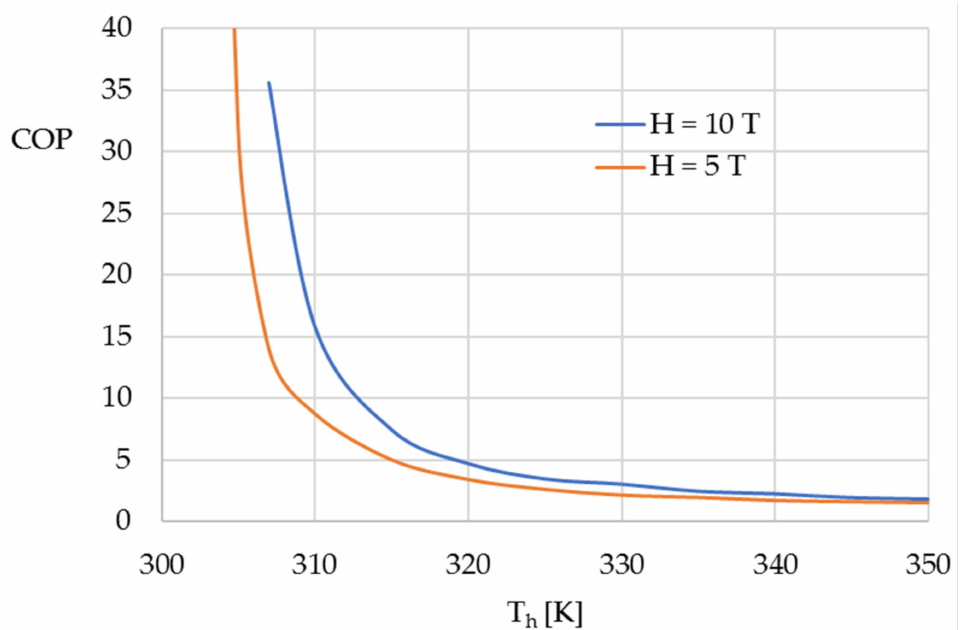
Figure 13. Theoretical COP, calculated with Langevin’s theory of statistical mechanics, as the temper- ature of the hot source T h varies for two different magnetic fields and with T l = 298